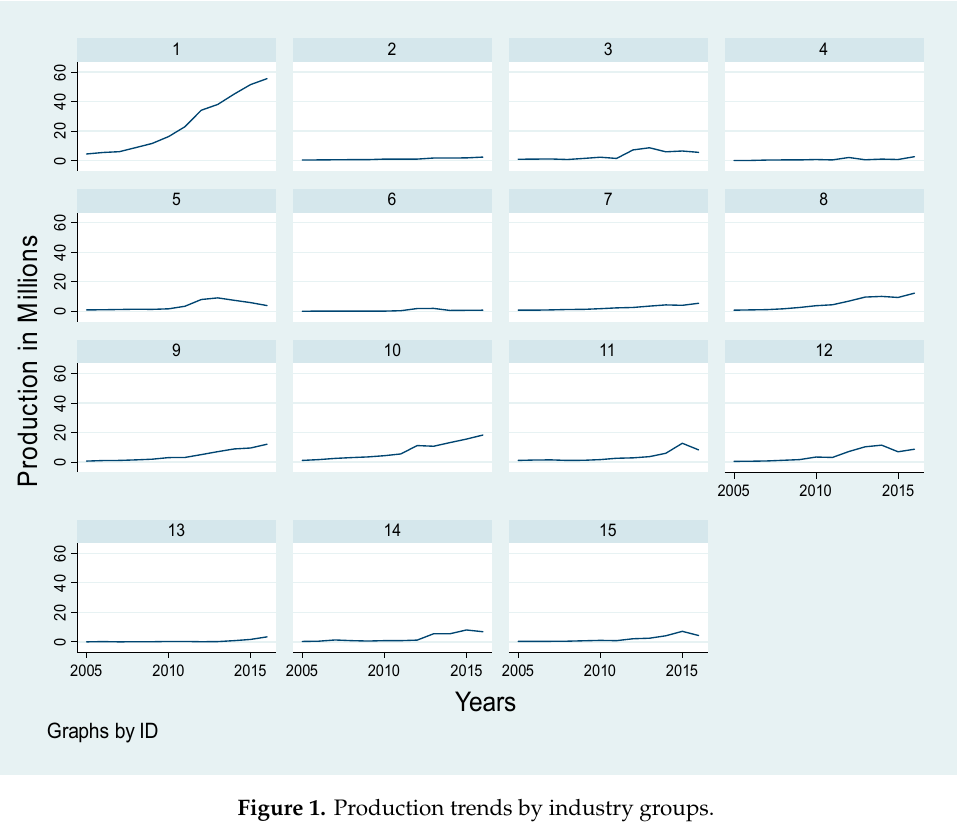
Energies 2019 , 12 , x FOR PEER REVIEW Figure 1. Production trends by industry groups. Figure 1. Production trends by industry groups.